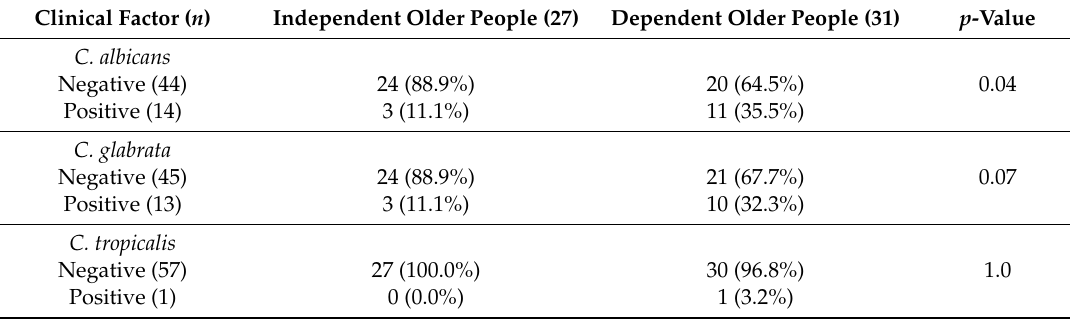
Table 2. Rates of oral Candida in independent and dependent older